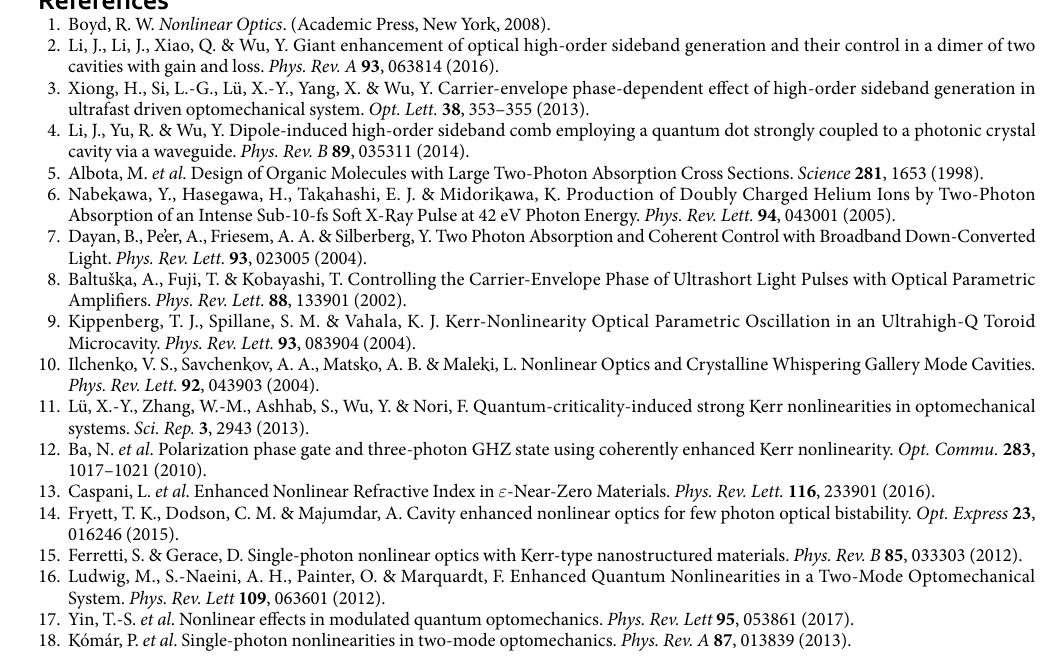
the results show that, when the QE spontaneous decay rate γ = 0, the trimer system will show a strict PT sym- metry; when γ has an actual value and is small enough compared with the total loss of the cavity, the PT -symmetric characteristics will weaken but still maintain the PT -broken point (BP). One of excellent applica- tions of this PT -symmetric trimer system is the enhanced transmission field and nonlinear characteristics, i.e. both the linear and nonlinear parts of the transmission field can be significantly enhanced, and the proportion of the nonlinear part gets improved. Even though in the unbalanced loss-gain case, the linear and nonlinear trans- mission parts can also be enhanced to a satisfactory degree in this trimer system. One can further maximize the linear and nonlinear transmission parts by adjusting the QE-cavity coupling strength, which is in order to set the system around the BP. In addition, there is a significant negative correlation between the gain degree of the linear (nonlinear) transmission part and the QE spontaneous decay, because the increasing of γ will break the balanced loss-gain condition of PT symmetry. This flexible and novel trimer proposal of ideal PT symmetry with more tuned parameters is feasible for experiments and may open up a new path to investigating the PT -symmetric optics of the low-light level. And the enhanced nonlinearity induced by this novel QE-cavity coupling may pro- vide a promising platform of controllable optical responses for fabricating photonic devices and controllable nonlinear optical media for quantum information and communication of photons.